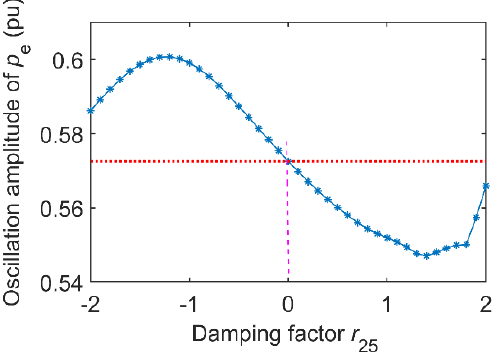
Figure 4. Amplitude change of p e with r 25 .